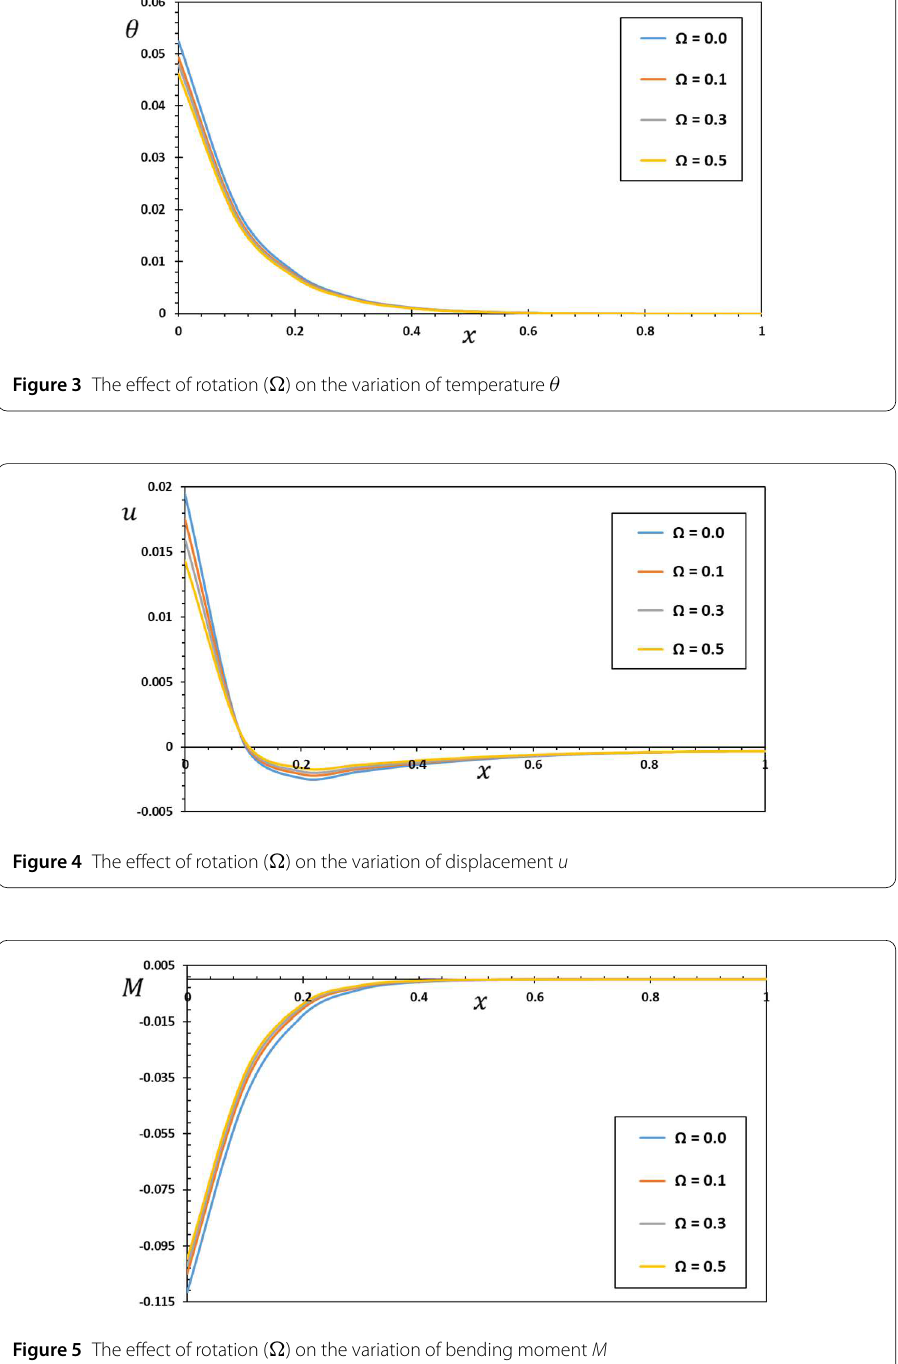
rise and reach their highest point at the first side of the beam as a result of the convective load that the beam is subjected to. Then, as x increases toward the other end of the beam, the heat wave’s ability to get there diminishes until it finally fades away. Changing the axial direction of the nanobeam lowers its temperature along its length. Contrary to the predic- tions made by the conventional theory of convection, heat waves travel through a